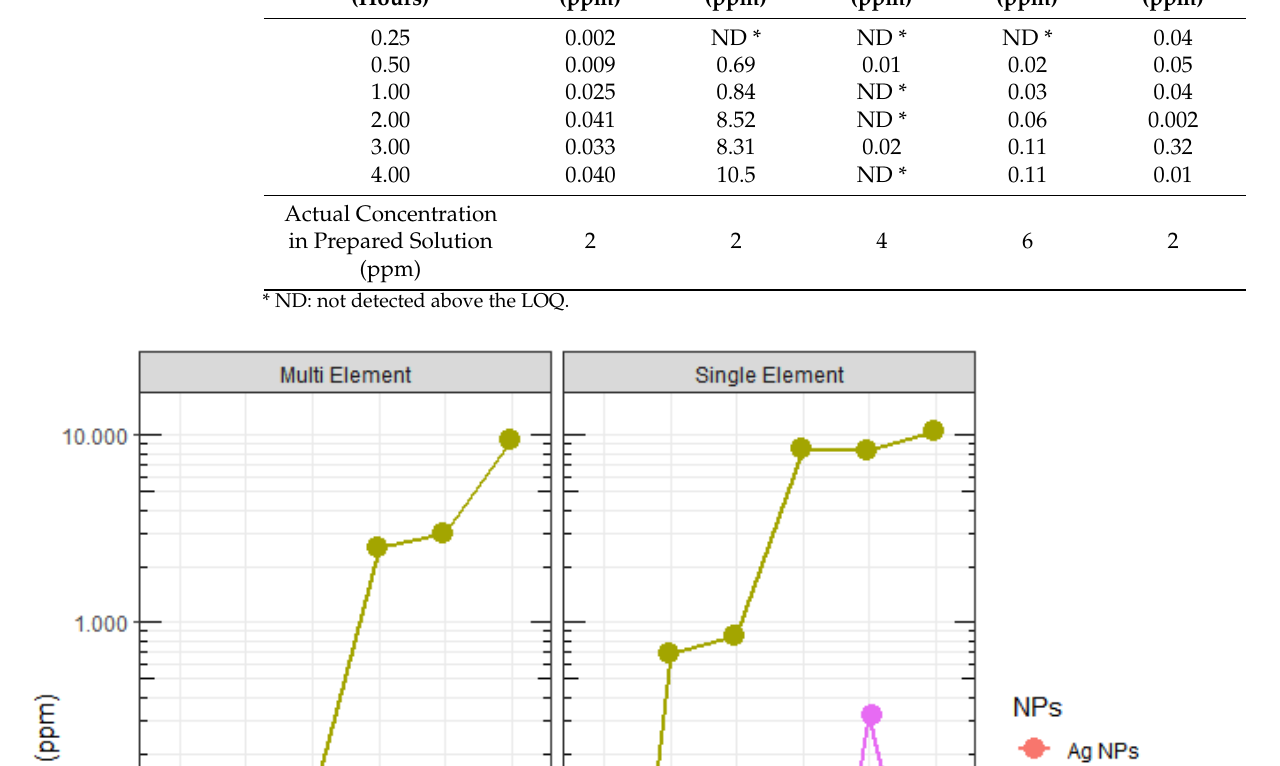
Table 4. Calculated recovery (%) of individual MNPs in different sonication times. Dispersion Time